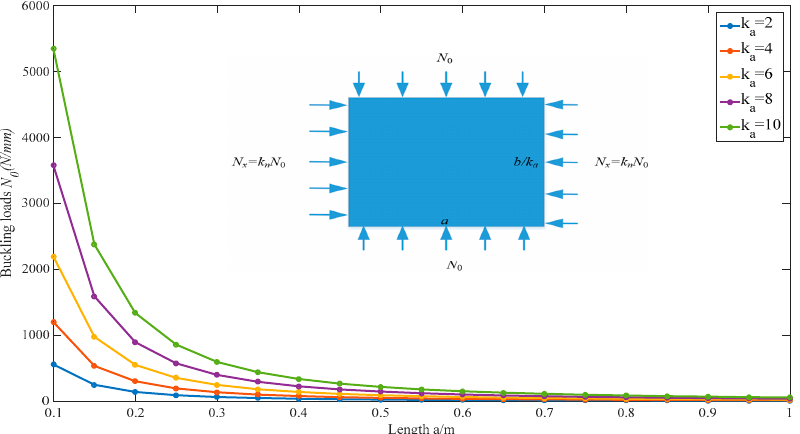
Figure 4. Buckling loads affected by geometrical parameter k a.